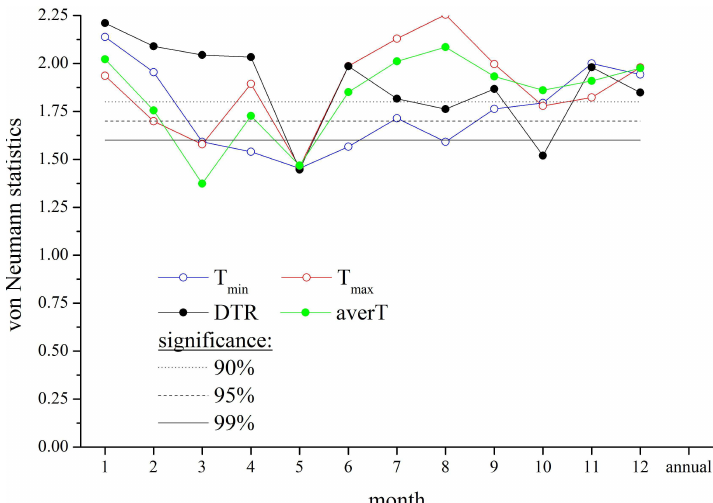
Figure 8. Porto: same as Fig. 4 but for the corrected series.